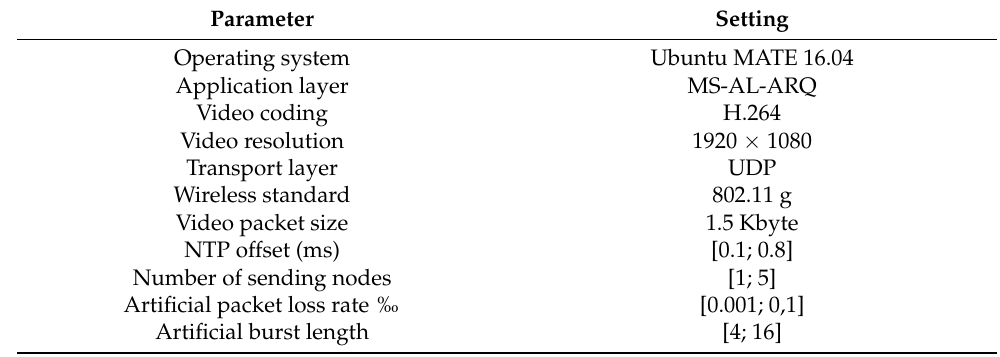
Table 1. Parameters of